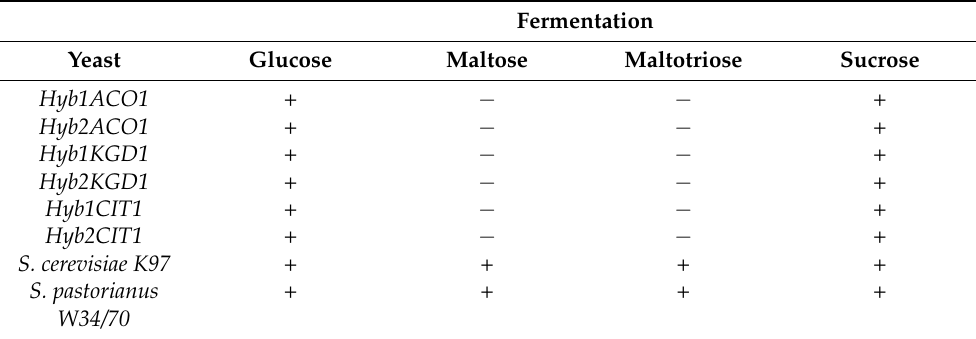
Table 4. The fermentation of saccharides of the constructed yeasts hybrids and standard brewer’s yeasts using Durham tubes at 25 ◦ C for 7